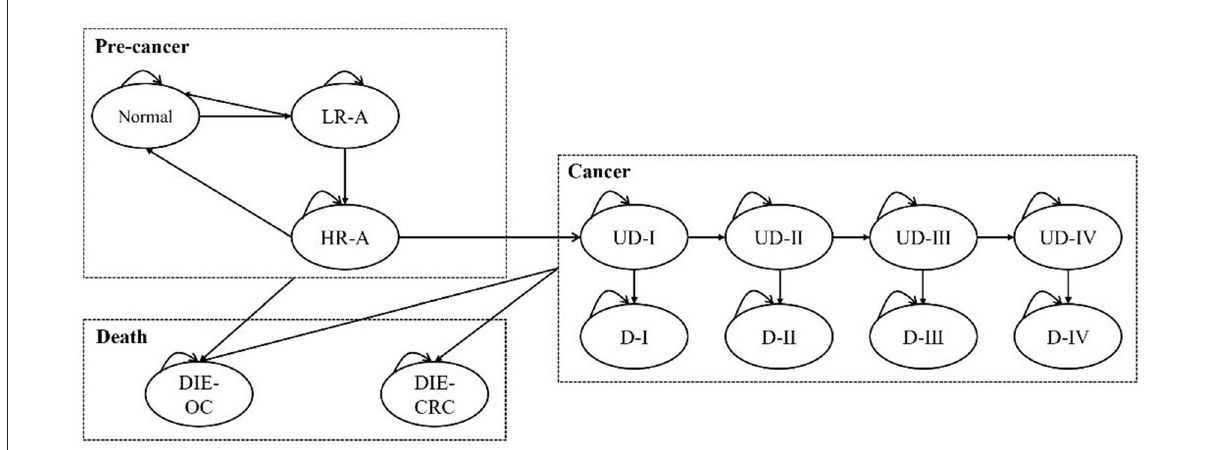
FIGURE1 The Markov model for the base case analysis. L/HR-A, low/high-risk adenoma; (U)D-I/II/III/IV, (undiagnosed) cancer at stage I/II/III/IV; DIE-CRC, die of colorectal cancer; DIE-OC, die due to other causes.